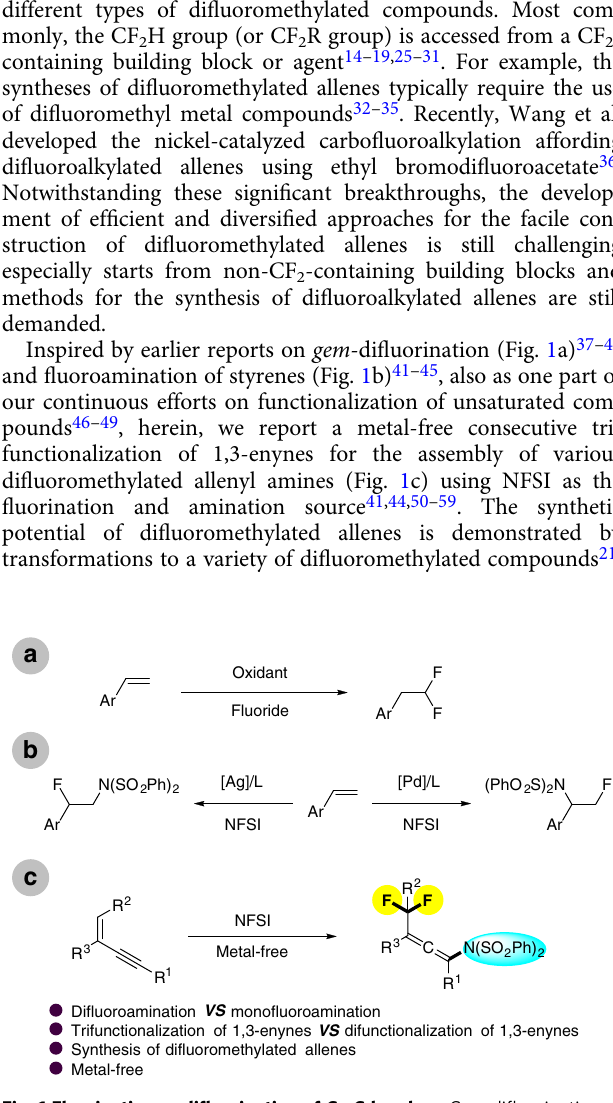
Fig. 1 Fluorination or di fl uorination of C = C bonds. a Gem -di fl uorination of styrenes. b Fluoroamination of styrenes. c This work: facile synthesis of di fl uoromethylated